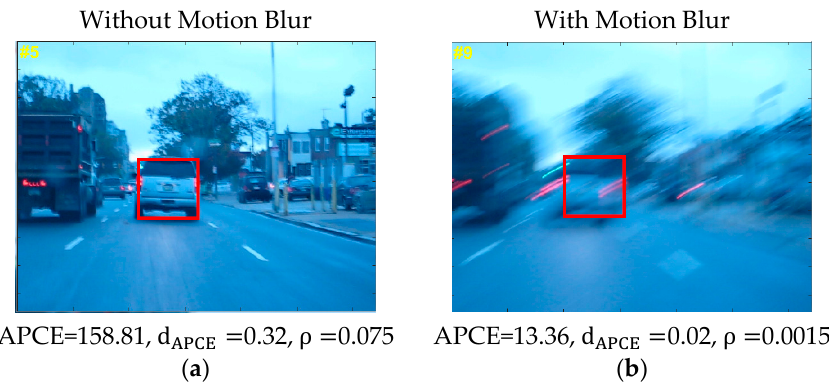
Figure 5. Learning rate mechanism. Pictures in the figure are part of OTB-100 dataset [26]. Algorithm 1: Proposed Tracking